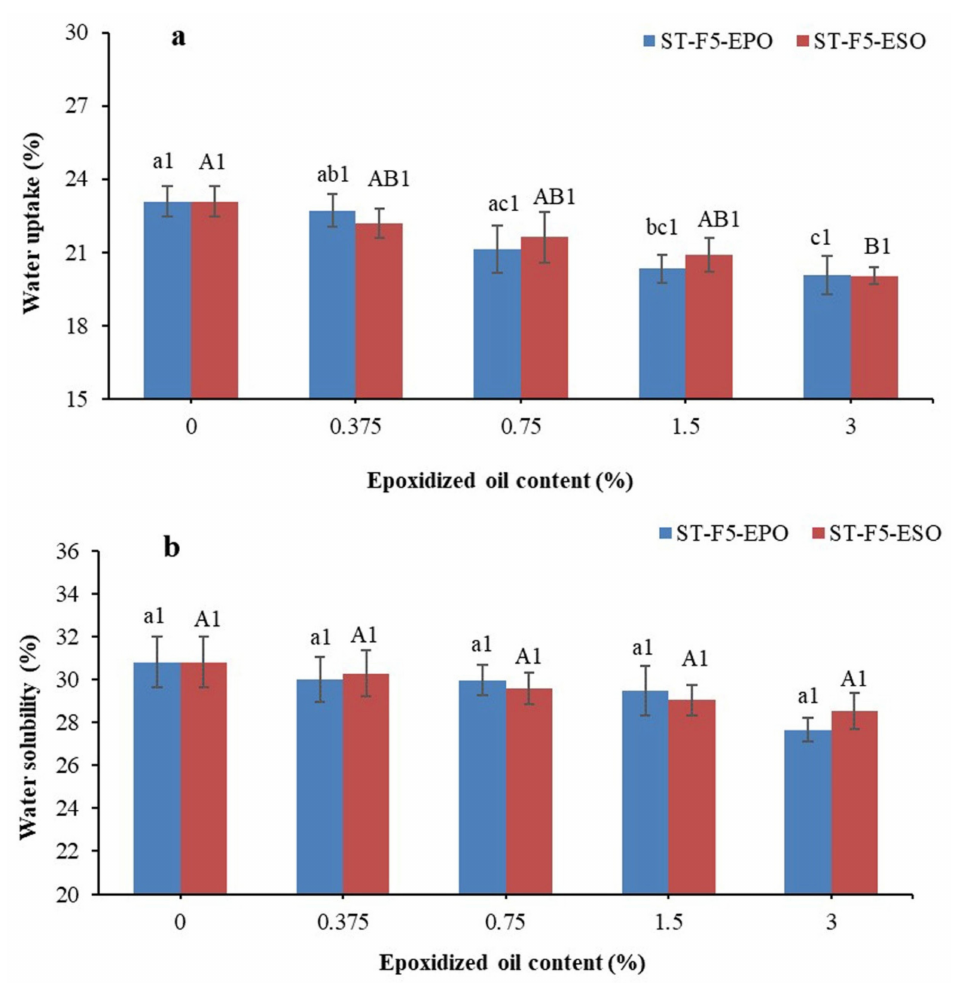
Figure 7. ( a ) Water uptake and ( b ) solubility of the bioplastic composites. In regard to a–c and A,B, different letters within the same indicator indicate significant difference among samples ( p < 0.05). (1) Same number indicates no significant difference between the formulations with PO and EPO at the same concentration ( p >